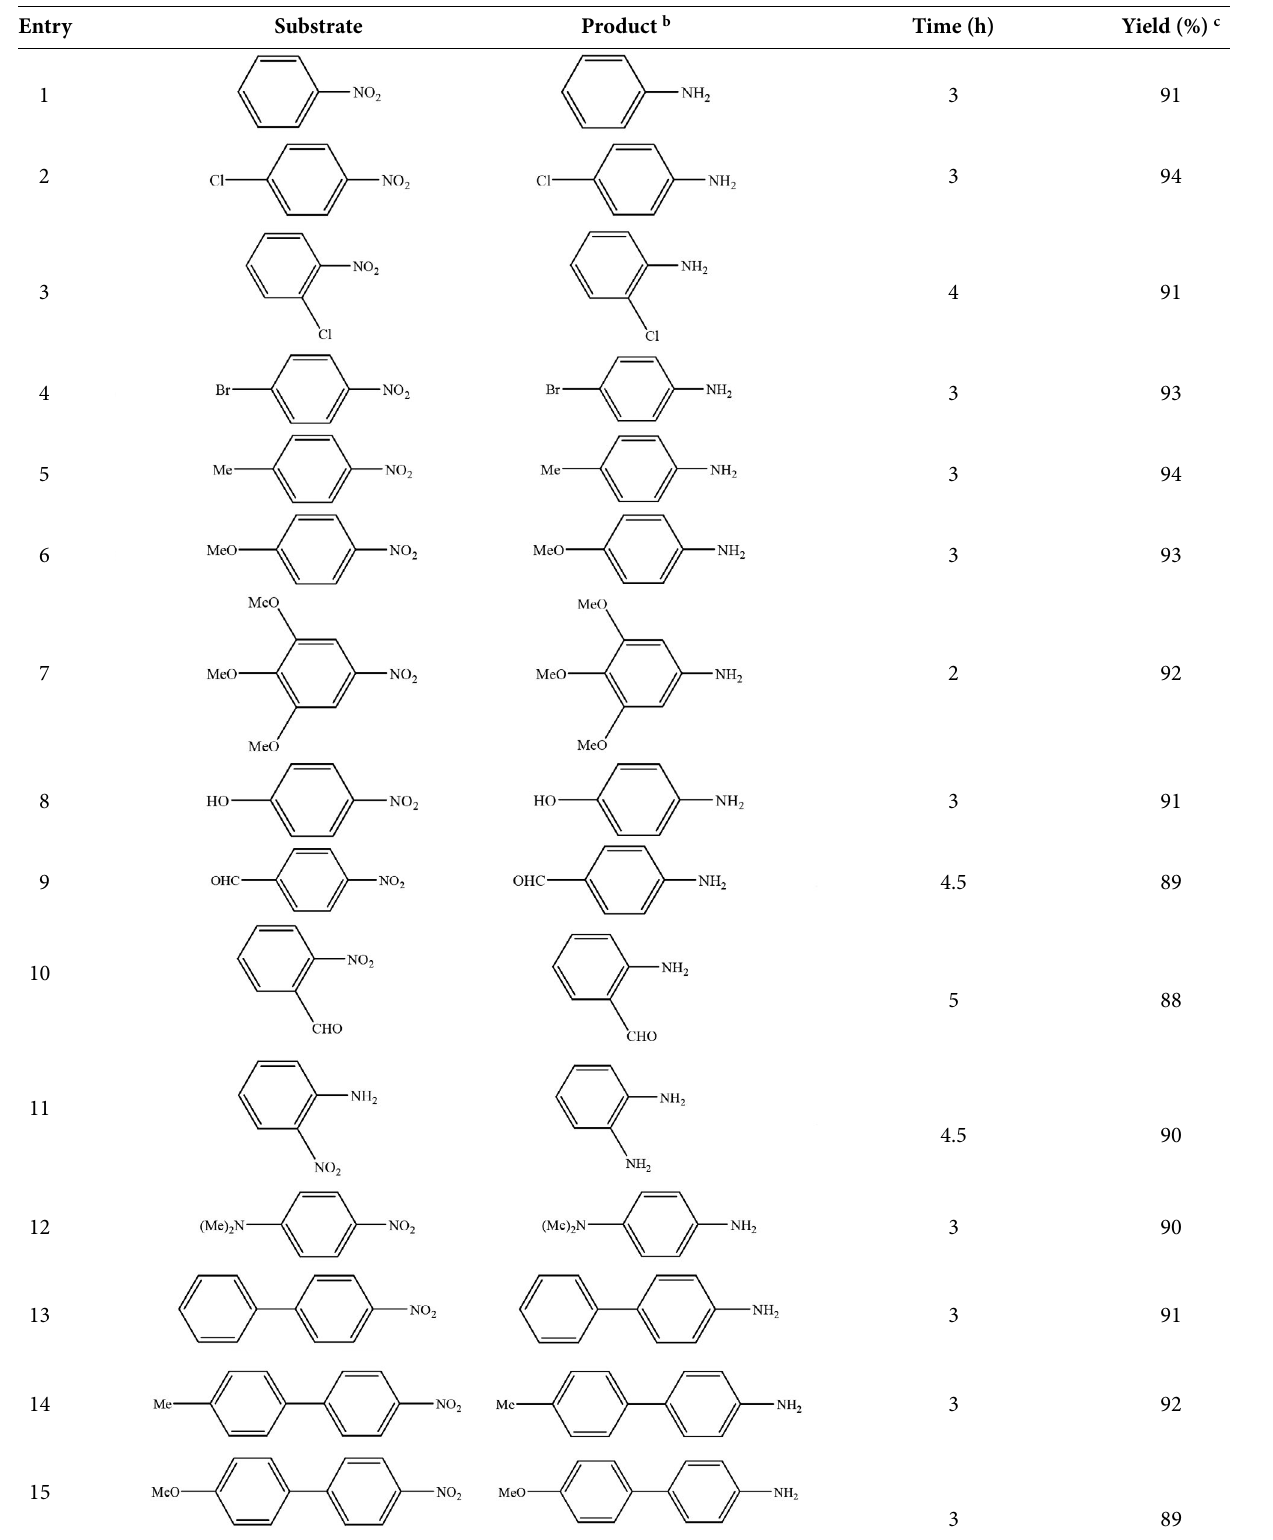
Table 3 . Chemoselective reduction of nitroarenes catalyzed by Co/Al 2 O 3 nanocatalyst. a